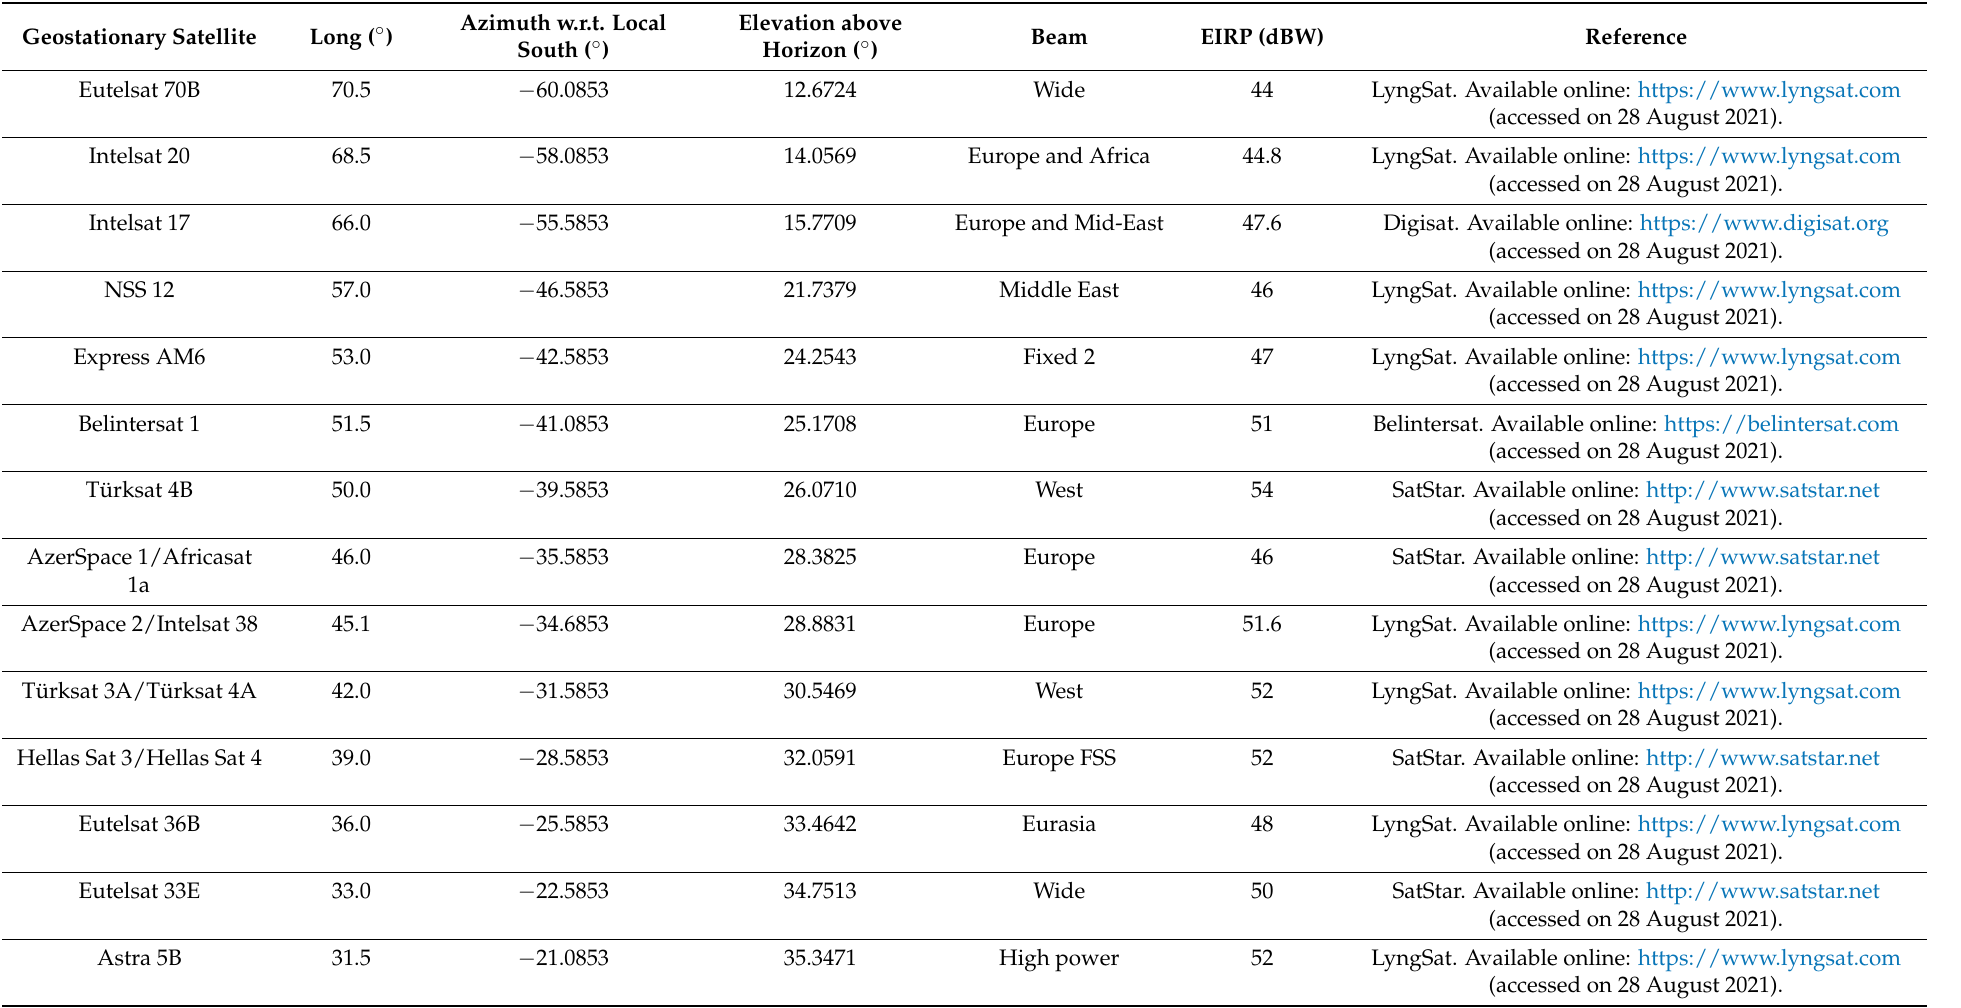
Table 2. List of geostationary satellites for DTH TV broadcasting in the Ku band Table 10 (4147 ◦ E, 43.7117 ◦